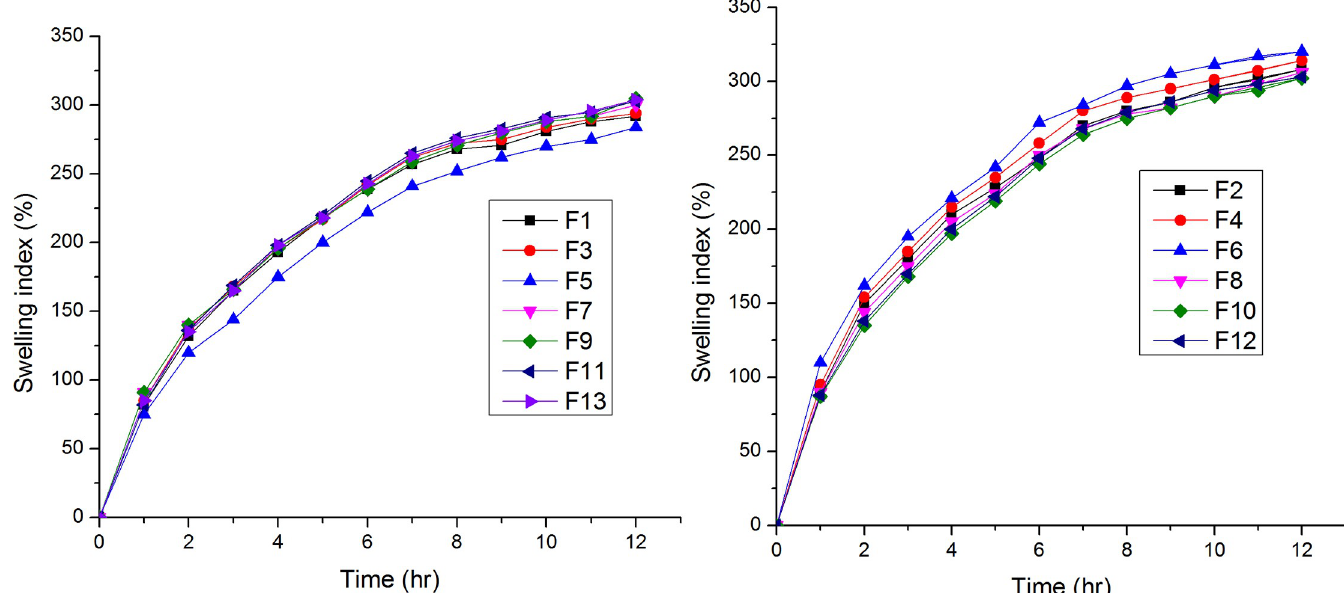
Fig 1. Swelling index profiles of ranitidine HCl matrix